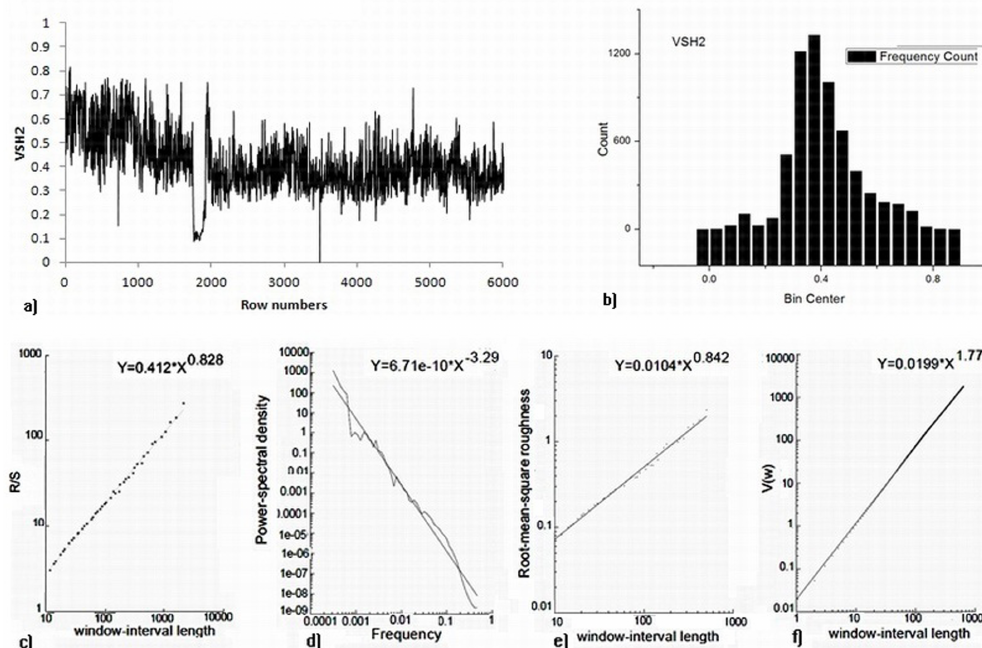
Fig. 2. Analysis for finding the fractal behavior of the traces used in our study, which reflected a typical fractional Gaussian noise. (a) Shale volume trace for well 2. (b) Histogram of the trace. (c) Rescaled Range analysis showing the characteristic fGn with Hurst coefficient H = 0 . 828. (d) Power spectrum analysis indicating power law behavior. (e) Roughness-Length method with H = 0 . 842. (f) Variogram analysis with Hurst coefficient H = 0 . 887, by using the BENOIT software.